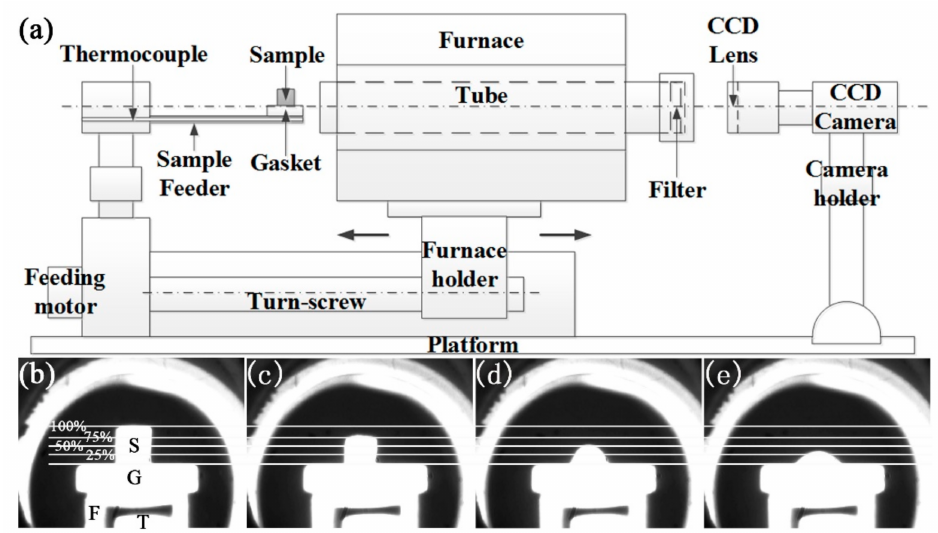
Figure 1. ( a ) Schematic diagram of the hot stage microscope and ( b – e ) silhouette photographs of samples at various stage. ( b – e are samples with a height of 100%, 75%, 50%, and 35%, respectively). Note: S, G, F, and T in Figure 1b denote the sample, gasket, feeder and thermocouple shown in Figure